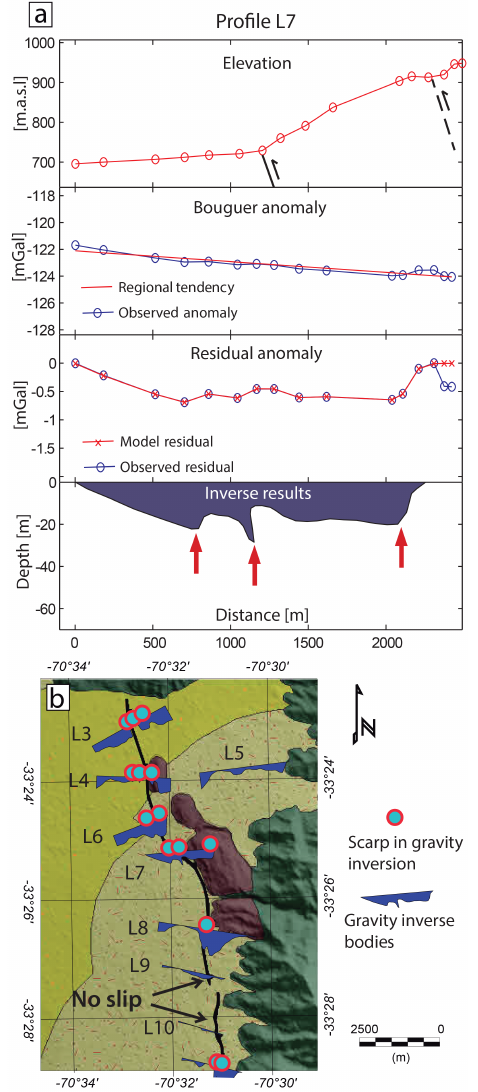
Figure 5. In the upper panel the results of gravity inversion of pro- file 7 are shown. In the elevation profile the observed surface scarp is drawn (Rauld, 2011). The regional tendency is calculated by a first order approximation. The inverse profile has a vertical exagger- ation of × 14, and the red arrow shows the interpreted faults scarp. In the lower panel, the results of profiles 3–10 are shown in planar view. Profiles L5, L9, and L10 do not have evidence of fault scarp in